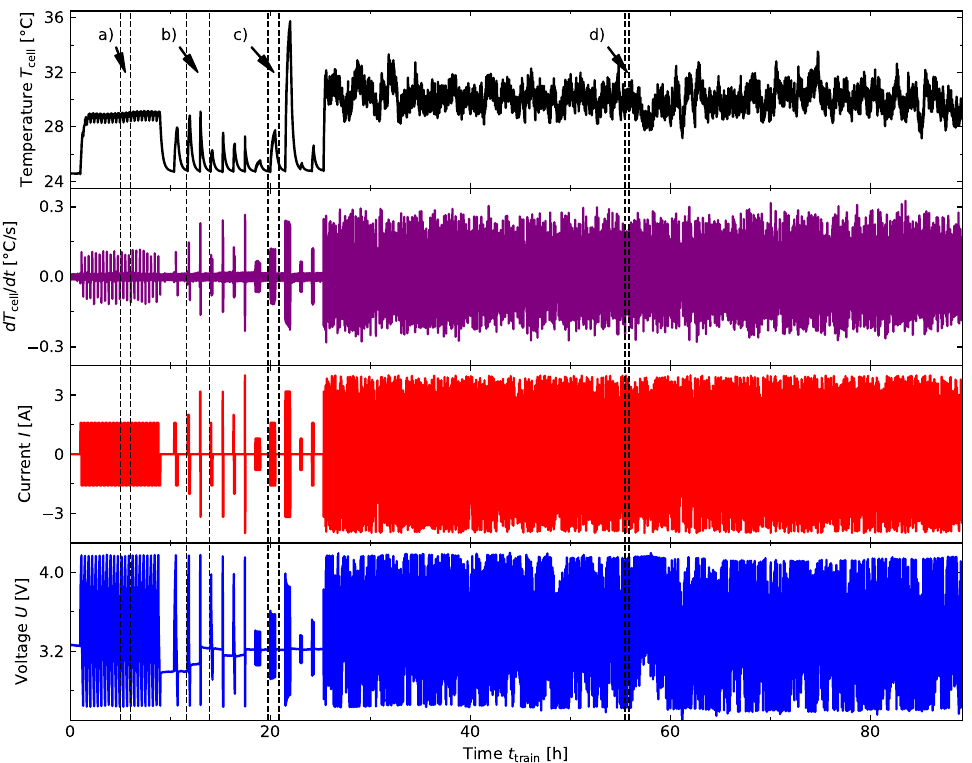
Figure 3. Selected data to train the algorithm. Presented are four subfigures showing temperature response T cell ( t train ) , temperature change over time dT cell / dt ( t train ) , current profile I ( t train ) and voltage response U ( t train ) . Four areas are marked ( a – d